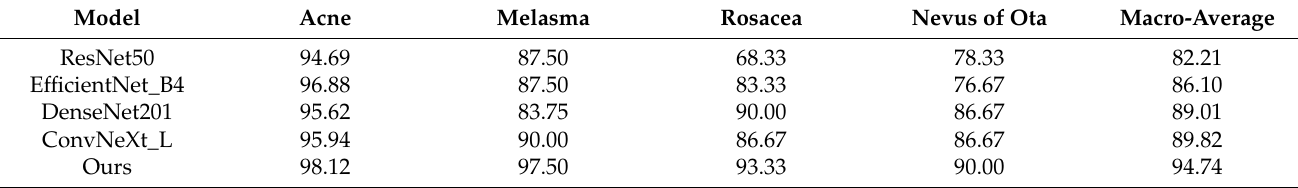
Table 3. The recall of each model on our private dataset; the unit is